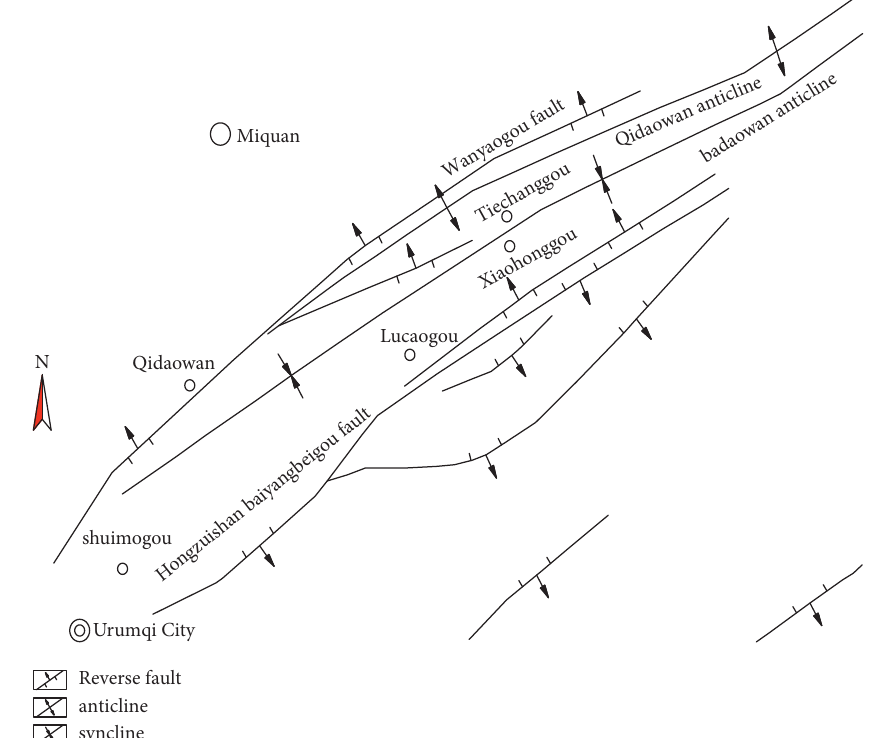
Figure 3: Characteristics of in situ stress in the Wudong